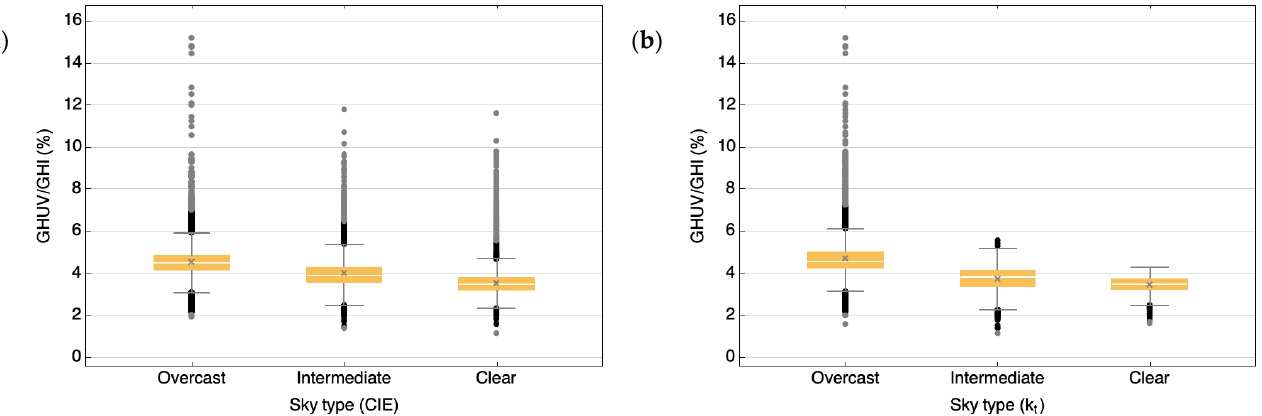
Figure 10. Boxplot of the GHUV/GHI average values for ( a ) each CIE sky type group and ( b ) for each sky type classification according to 𝑘 (cid:3047) , based on the 10 min datasets. Table 6. Mean, standard deviation (STD), and interquartile range (IQR) of the GHUV/GHI average values (%), based on the 10 min datasets for clear, intermediate, and overcast sky types, which were classified according to the 𝑘 (cid:3047) and CIE criteria .